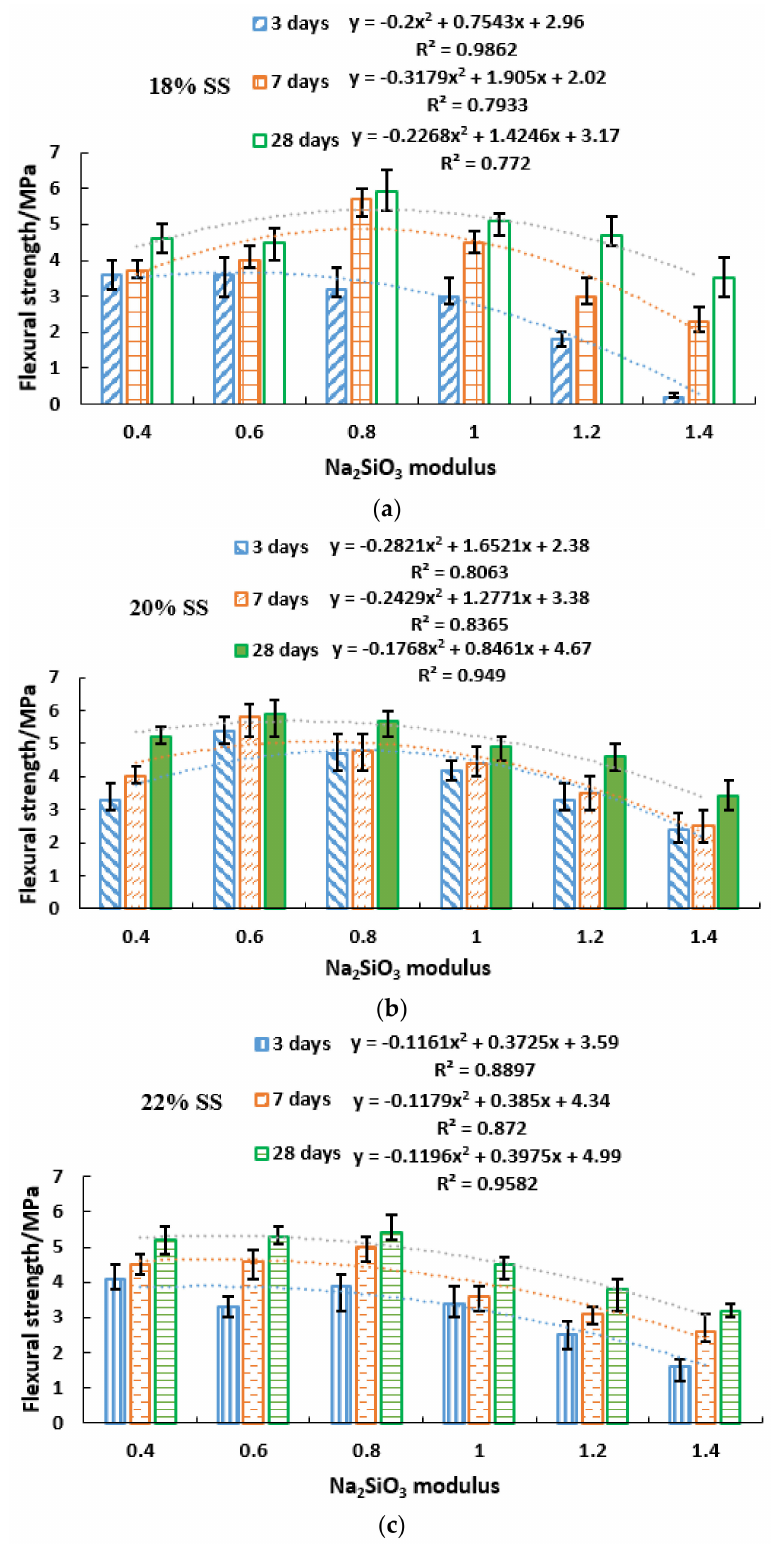
Figure 9. Flexural strength of different modulus geopolymers at 3, 7, 28 days. ( a ) 18% SS ( b ) 20% SS ( c ) 22%